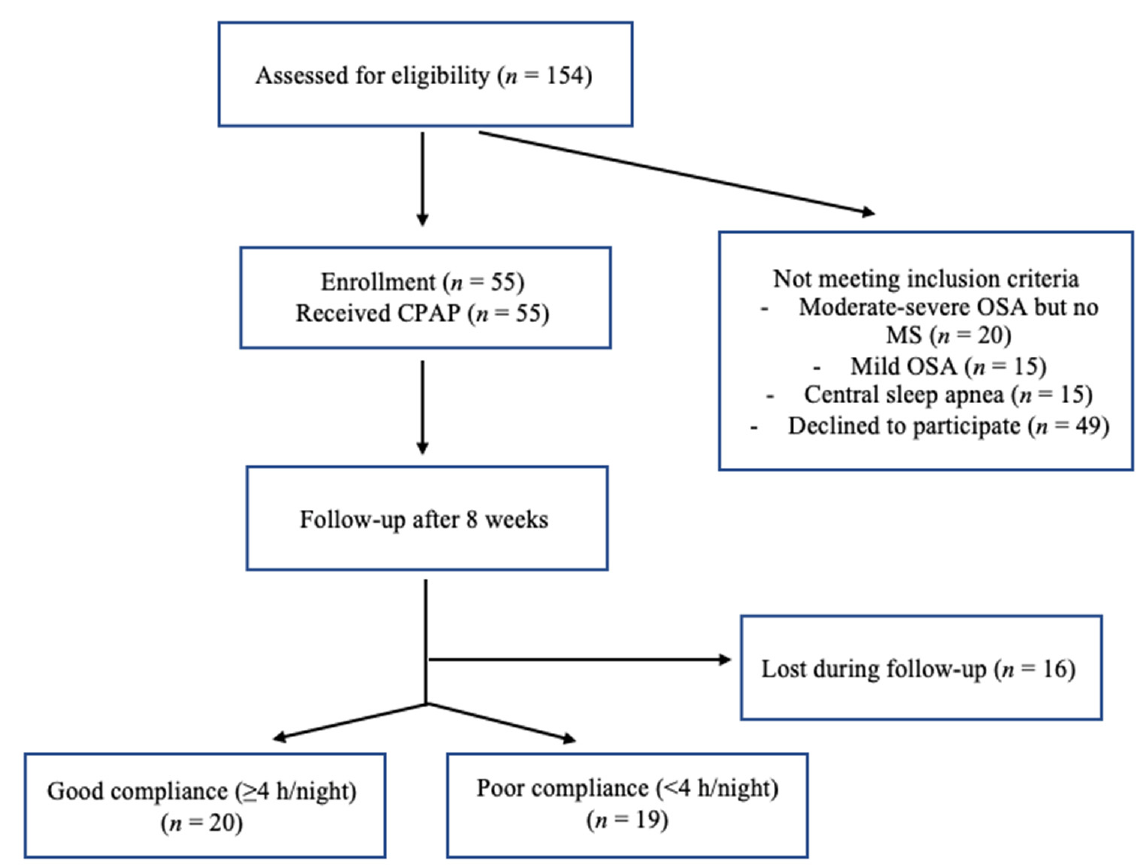
Figure 1. Flowchart diagram of patients examined in the sleep unit between January and December 2018; OSA: obstructive sleep apnea; MS: metabolic syndrome; CPAP: continuous positive airway therapy.